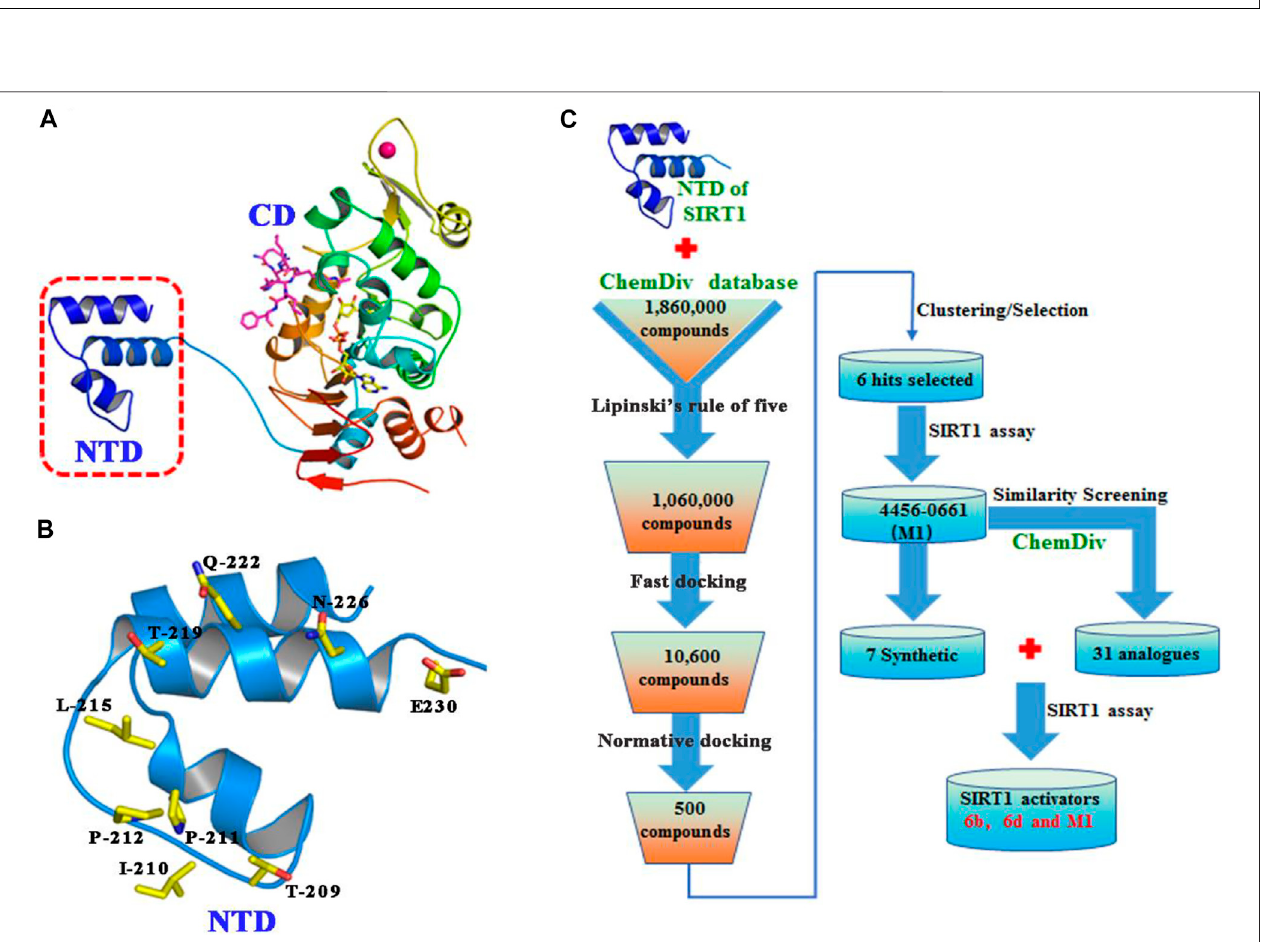
Frontiers in Pharmacology |